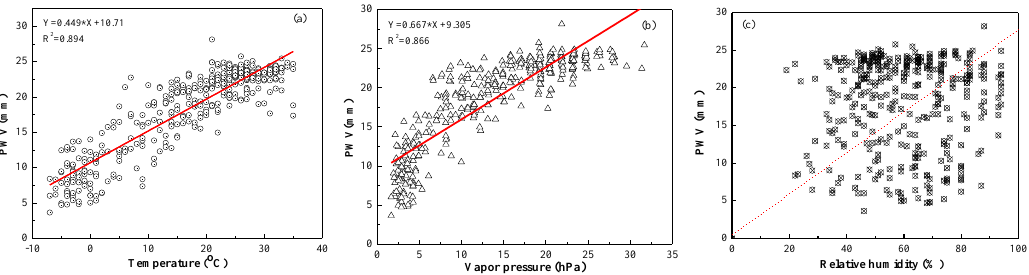
Figure 9. Correlations between PWV and atmospheric temperature, vapor pressure and humidity. ( a ) temperature; ( b ) vapor pressure; ( c ) relative humidity.